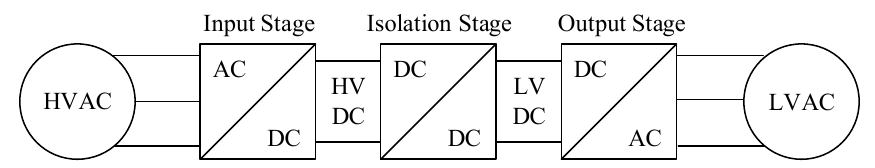
Figure 1. Structure of a three-stage solid state transformer.